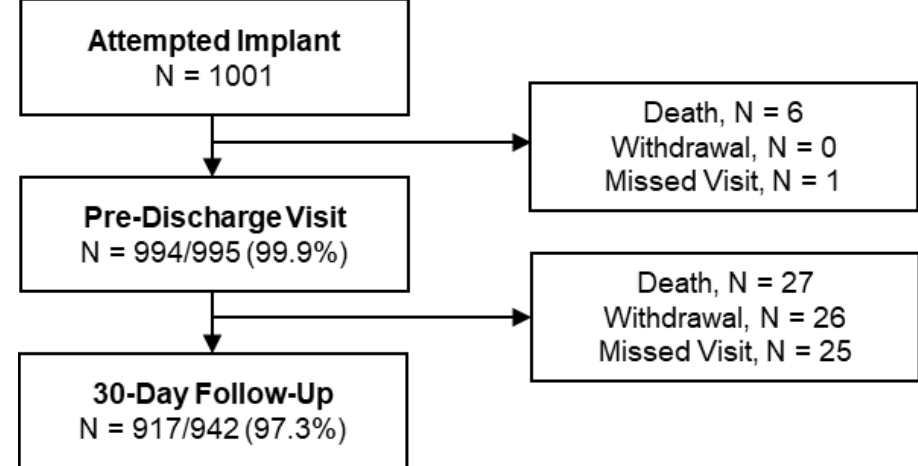
Figure 1. Subject disposition through 30 days after transcatheter aortic valve implantation. A total of 917 30-day visits were completed for 942 subjects eligible for follow-up. Table 1. Demographics and clinical